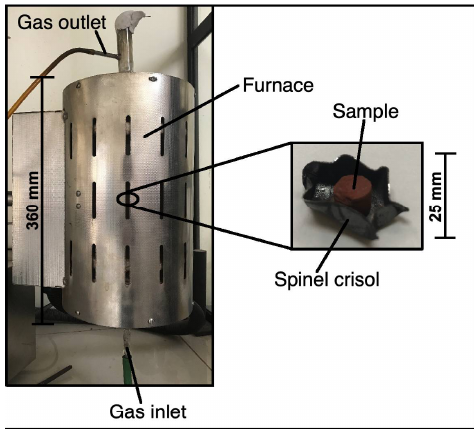
Figure 1. Electrical furnace (Nabertherm RT 30-200) used in experiments and a sample placed within the silica